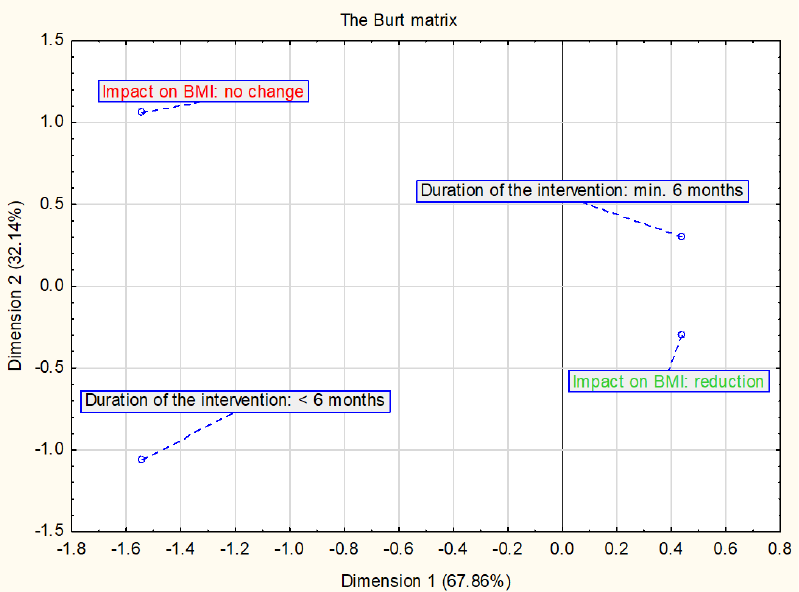
Figure 6. Presentation of the correspondence analysis results defining the relationship between the changes in BMI and/or BMI z-score and duration of the intervention ( n = 23).